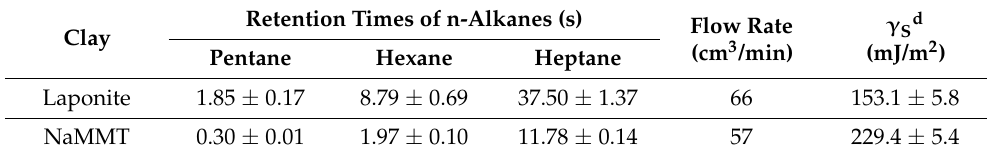
Table 3. Results of the IGC measurement.